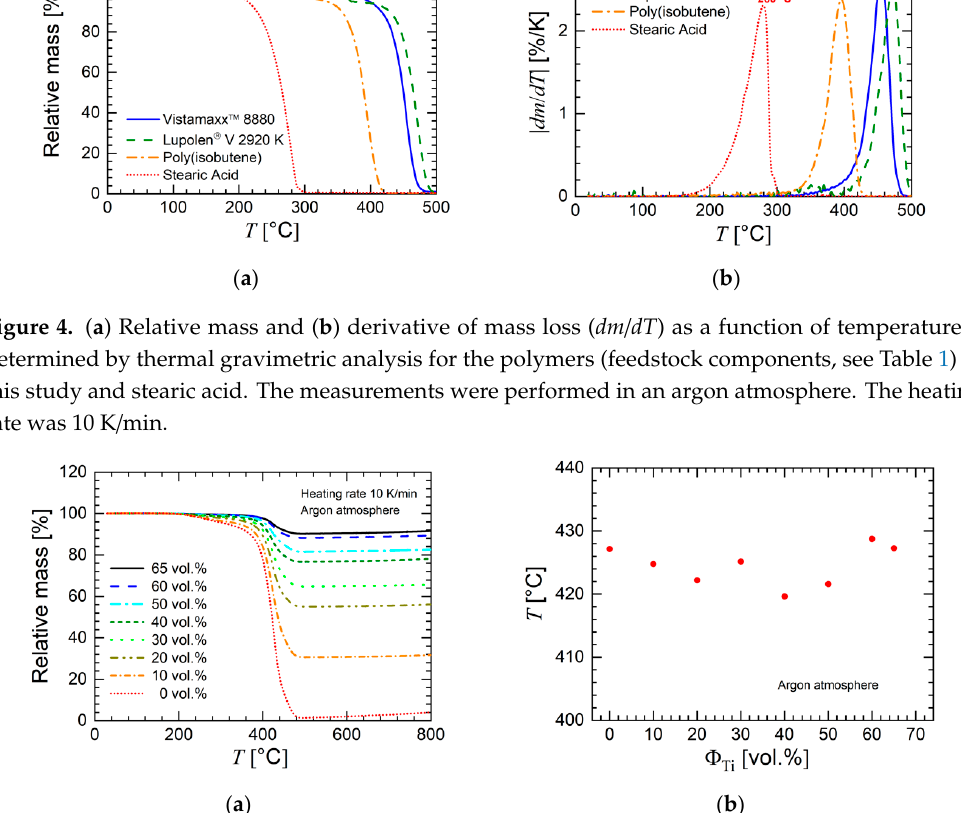
Figure 3. Scanning electron micrograph of Ti particles of this study.